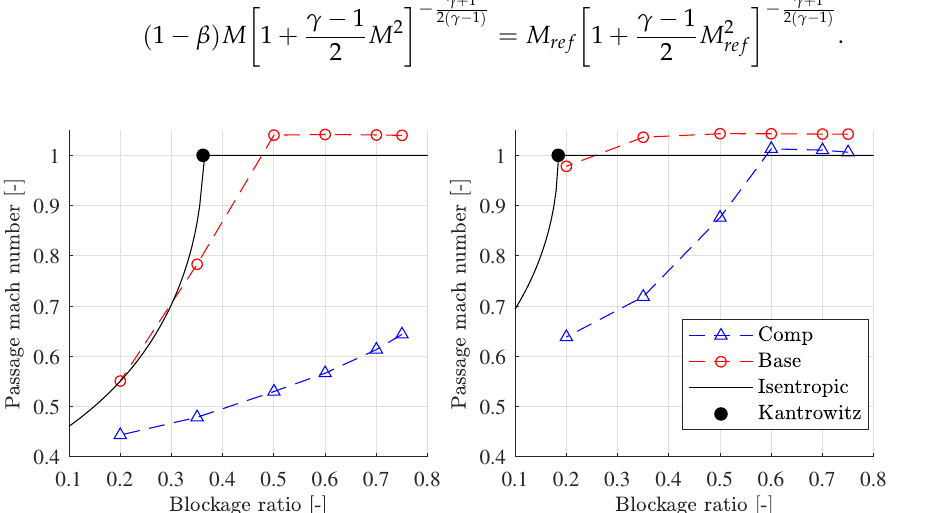
Figure 14. Mach number at the end of the passage for 500 km/h or Mach 0.408 ( left ) and 700 km/h or Mach 0.571 ( right